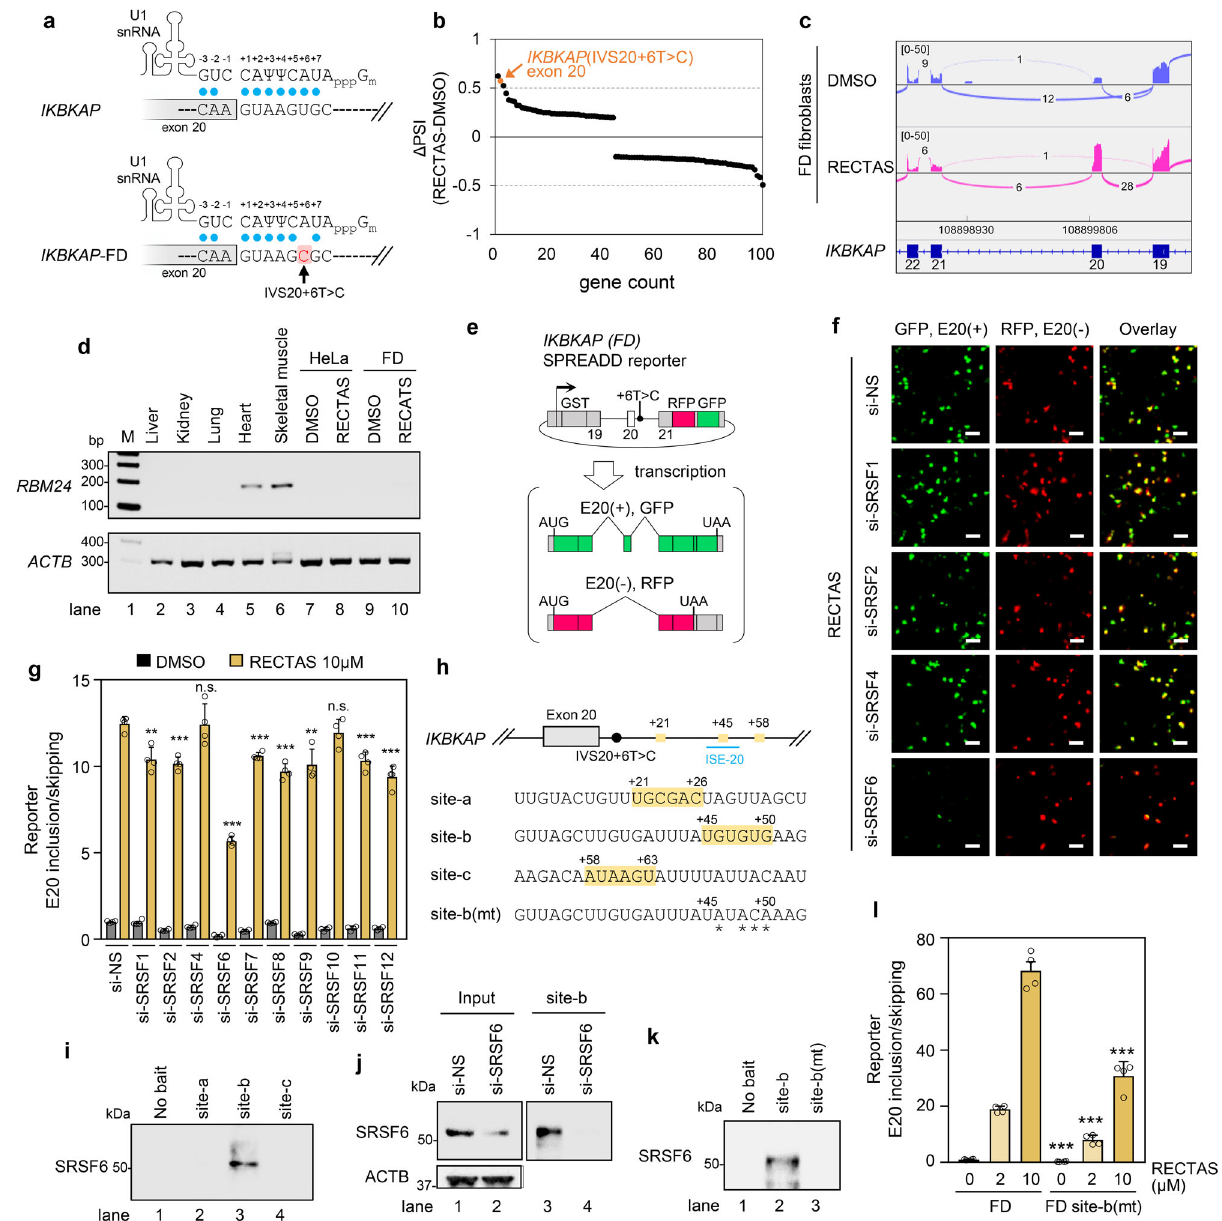
Fig. 1 IKBKAP- FD exon 20 requires SRSF6 binding to an ISE. a The IKBKAP exon 20 5 ′ splice site has nearly optimal pairing to U1 snRNA, whereas the IVS20 + 6 T > C creates an additional mismatch at + 6 position, resulting in suboptimal recognition by U1 snRNP. Blue dots indicate base pairing. b Top 100 differential splice events by | Δ PSI (PSI RECTAS -PSI DMSO ) | following RECTAS treatment (2 µ M, 8 h) in FD patient fi broblasts. c Sashimi plot with junction read number of IKBKAP- FD exon 19 – 22 for DMSO- or RECTAS-treated FD patient fi broblasts. The displayed read count range was set to 0 – 50. d RT-PCR for RBM24 expression in human tissues, and cell lines treated with 10 µ M RECTAS or 0.1% DMSO for 24 h. RBM24 and ACTB were detected with primers oAM669 + oAM671 and oAM13 + oAM14, respectively. e Diagram of reporter system for IKBKAP -FD exon 20 splicing 13,17 . GFP is translated when exon 20 is included (E20( + )), whereas RFP is translated when it is skipped (E20( − )). f , g Microscopic images ( f ) and quanti fi cation of IKBKAP -FD exon 20 inclusion ( g ), following treatment with RECTAS (10 µ M) or 0.1% DMSO for 24 h in HeLa cells transfected with the indicated siRNAs for 72 h. h SRSF6- binding motifs starting at + 21 nt (site-a), + 45 nt (site-b), and + 58 nt (site-c), predicted by ESE fi nder 3.0 28,29 are shown. RNA sequences for pull-down assays are indicated. Asterisks in site-b(mt) indicate mutated ribonucleotides. ISE-20 from Sinha et al. 30 is also indicated. i – k Western blot of SRSF6 by 1H4 antibody for RNA pull-down products or no bait RNA control for HeLa cells ( i ), site-b pull-down products for HeLa cells treated with siRNA for 72 h ( j ), and site-b and site-b(mt) RNA pull-down products for HeLa cells ( k ). l Quanti fi cation of IKBKAP exon 20 inclusion rate, following RECTAS treatment for 24 h in HeLa cells with IKBKAP- FD or site-b(mt)-mutant IKBKAP (FD site-b(mt)) reporter. Data from four replicates are shown in ( f ), ( g ), and ( l ), and two replicates are shown in ( i ), ( j ), and ( k ). Representative data of two experiments are shown in ( d ). Columns, mean; bars, SE; n.s., P ≥ 0.05; ** P < 0.01; *** P < 0.001 for unpaired two-tailed t test in ( g ) (vs. the RECTAS 10 µ M of si-NS: si-SRSF1, P = 2.3 × 10 − 3 ; si-SRSF2, P = 1.7 × 10 − 4 ; si-SRSF4, P = 0.94; si-SRSF6, 1.5 × 10 − 7 ; si-SRSF7, P = 1.9 × 10 − 4 ; si-SRSF8, P = 1.0 × 10 − 4 ; si-SRSF9, 3.0 × 10 − 3 ; si-SRSF10, P = 0.28; si-SRSF11, P = 6.1 × 10 − 4 ; si-SRSF12, P = 1.8 × 10 − 4 ) and ( l ) (vs. the FD of corresponding RECTAS concentration: 0 µ M, P = 2.0 × 10 − 4 ; 5 µ M, P = 4.4 × 10 − 5 ; 10 µ M, P = 1.0 × 10 − 4 ).